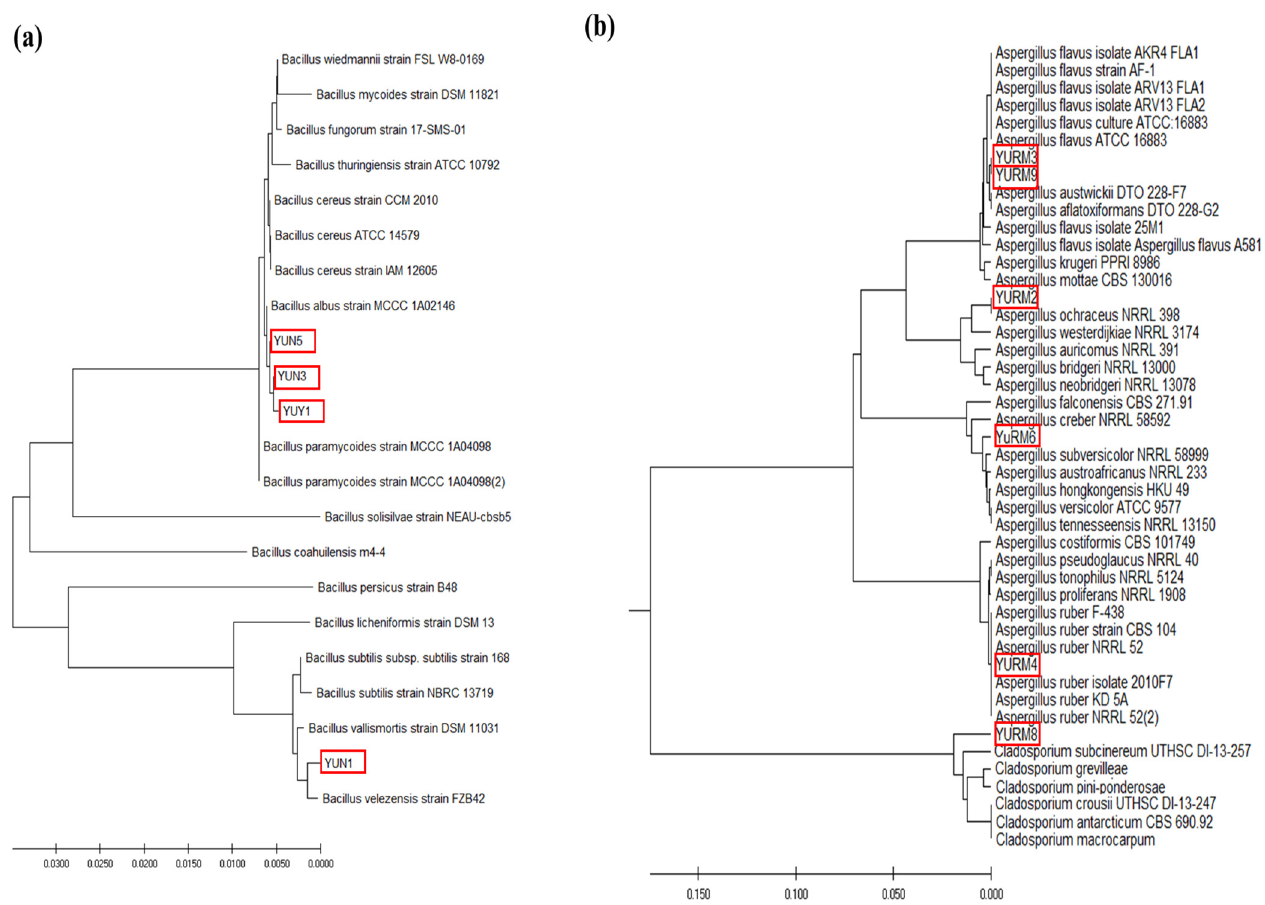
Figure 7. Comparative phylogenetic analysis of aflatoxin-degrading bacteria ( a ) and fungi ( b ) from doenjang samples. The phylogenetic tree was constructed using the MEGA6.0 software by employing the neighbor-joining method.